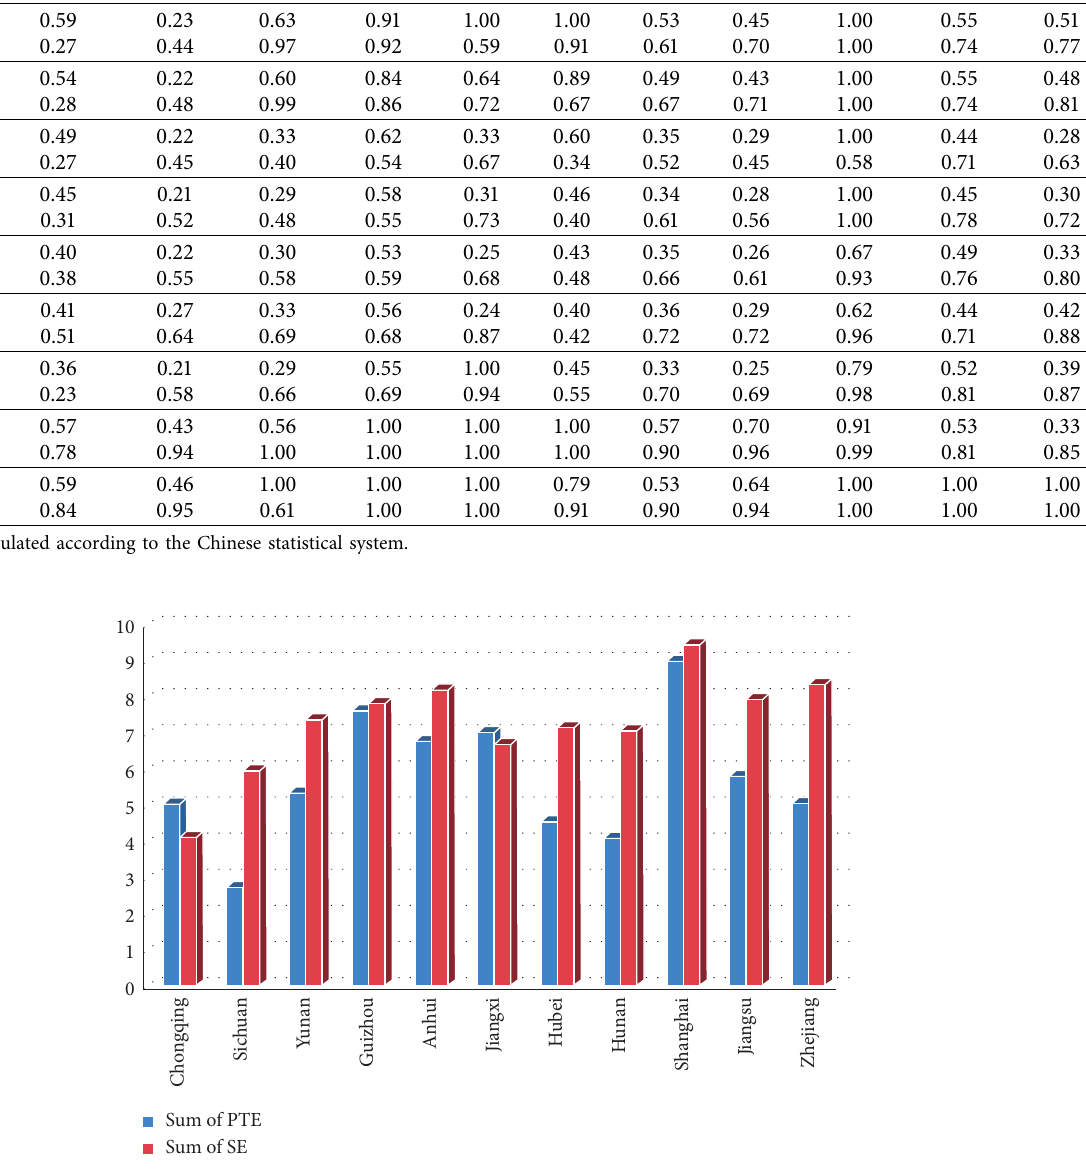
Figure 4: PTE and SE of the logistics industry in the provinces and cities in the Yangtze River Economic Belt from 2010 to